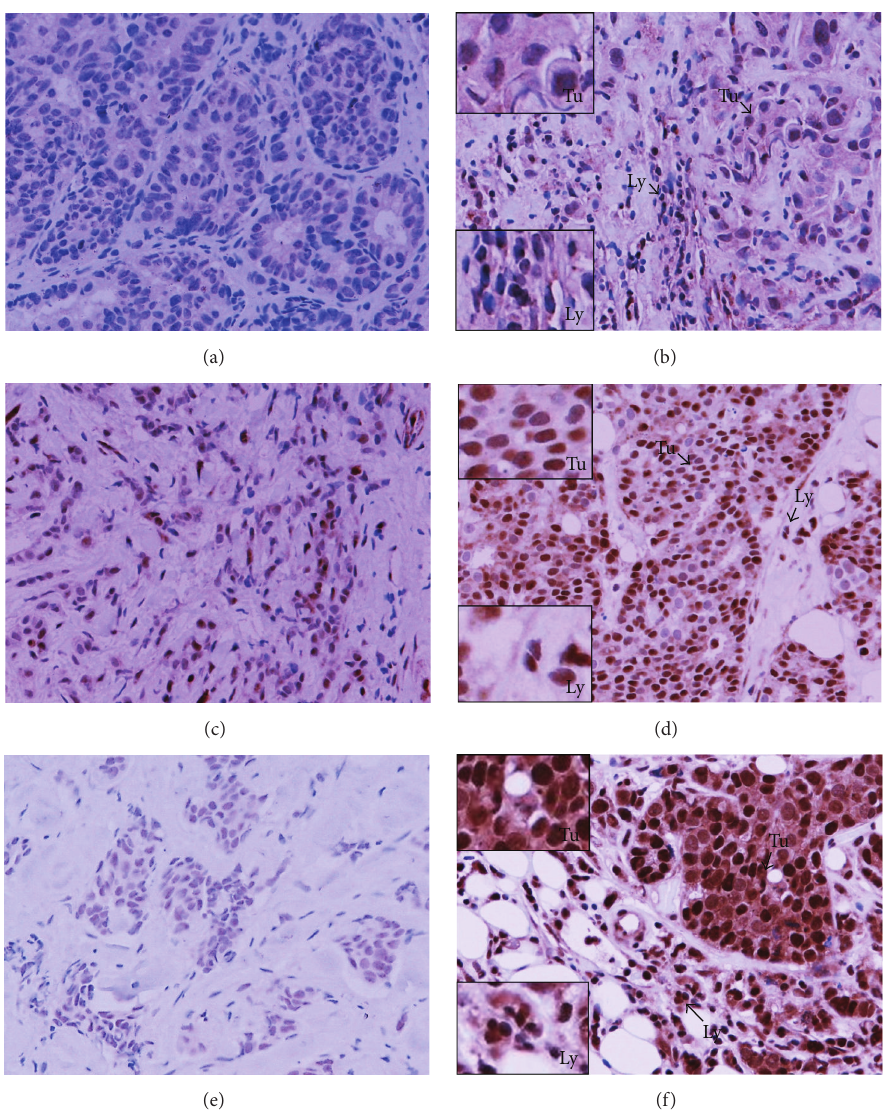
Figure5:IL-1(a,b),IL-2(c,d),andIFN- 𝛾 (e,f)expressioninthesectionsofLLABCs,usingIHCstaining,at400xmagnification.Briefly,heat- mediated antigen retrieval was performed using citrate buffer, pH 6 (20 mins). The sections were then incubated with MAbs to IL-1 (Abcam, ab8320) at a 1: 150 dilution overnight at 4 ∘ C and MAbs to IL-2 (Abcam, ab92381) at a 1: 500 dilution for 30 mins at RT and polyclonal Abs to IFN- 𝛾 (Abcam, ab9657) at a concentration of 4 𝜇 g/mL for 30 mins at RT, respectively. Polymeric HRP-linker antibody conjugate was used as secondary antibody. DAB chromogen was used to visualize the staining. The sections were counterstained with haematoxylin. (a, c, e) Low level of expression; (b, d, f) high level of expression. The 𝐻 score (% of positive cells (brown membrane/cytoplasmic-stained tumour